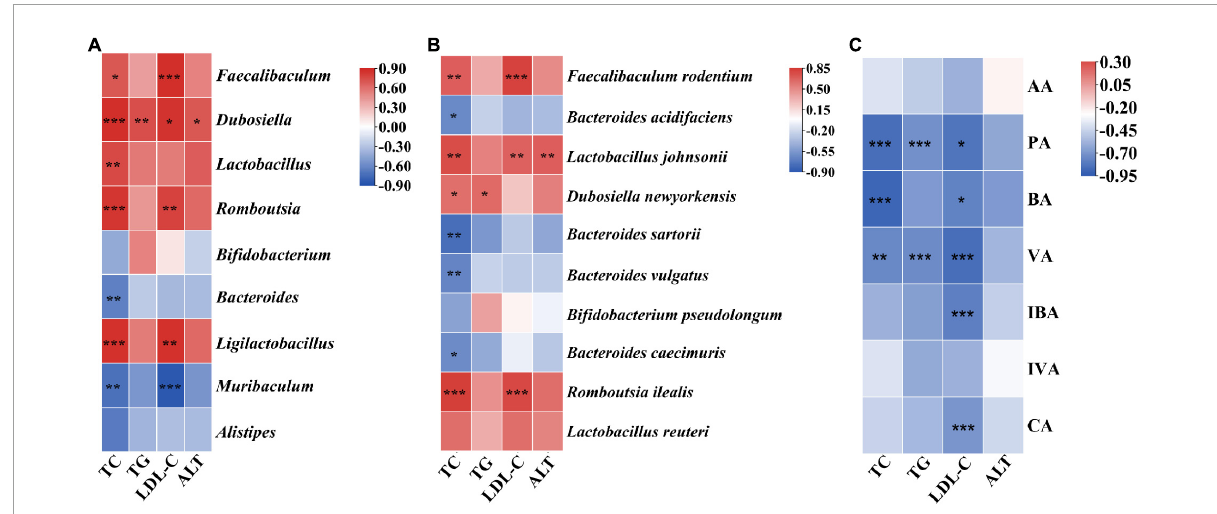
FIGURE6 Association analysis of biochemical parameters of serum and gut microbiota at the genus level (A) . Association analysis of biochemical parameters of serum and gut microbiota at the species level (B) . Association analysis of biochemical parameters of serum and SCFAs (C) . ∗ , significant difference ( P < 0.05), ∗∗ and ∗∗∗ , highly significant difference ( P < 0.01 and P < 0.001).